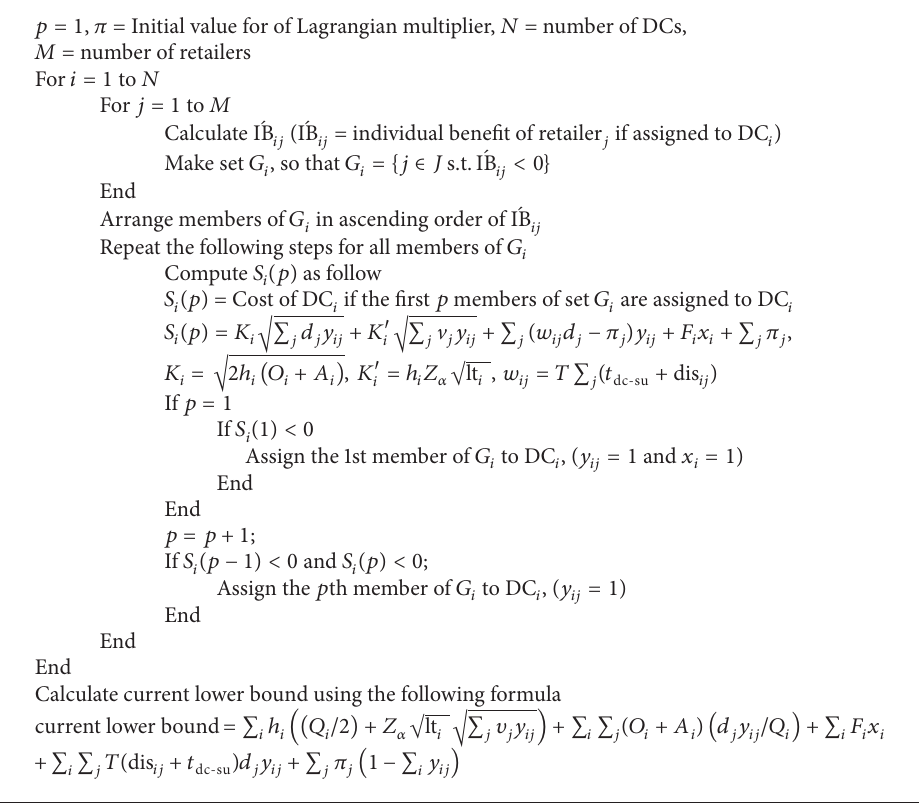
Algorithm 1: Lower bound